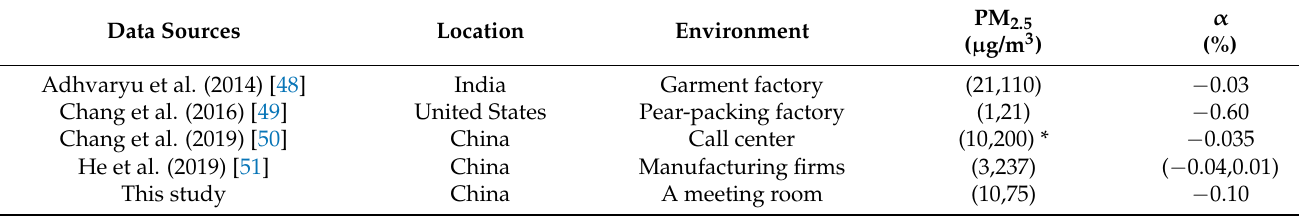
Table 9. Comparison of the rates of performance change in different studies.